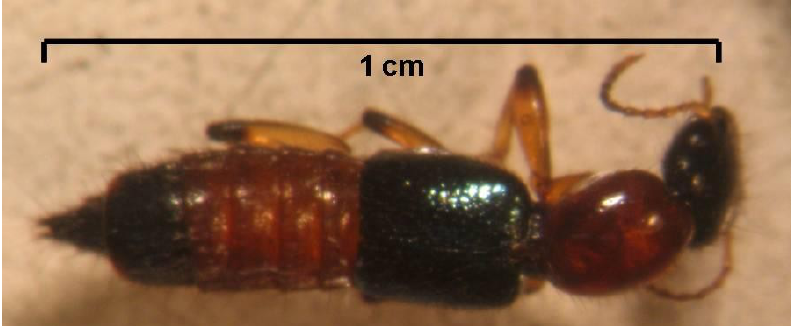
Figure 9. Paederus ilsae , the predominant species in Darab, Fars province, southern Iran.